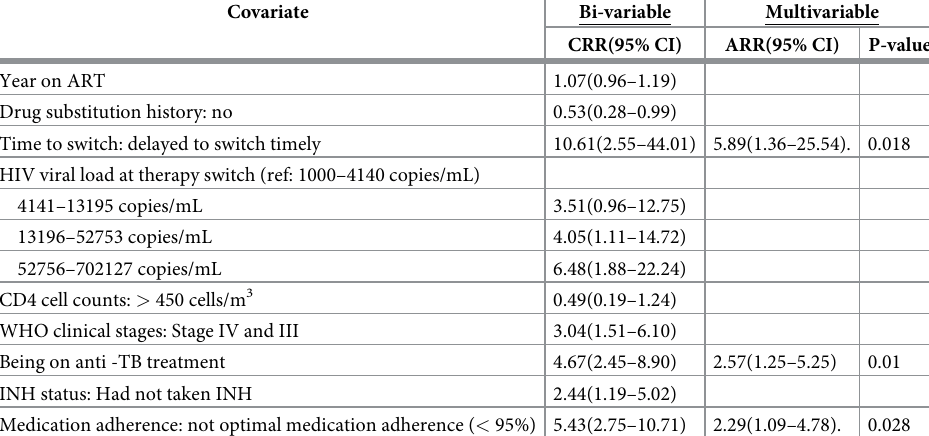
Table 3. Bi-variable and multivariable poisson regression model on determinants of second-line treatment failure among PLWHIV on second-line therapy, Dessie comprehensive Specialized Hospital, northeast Ethiopia, October 2016—November 2019. (n = 568).